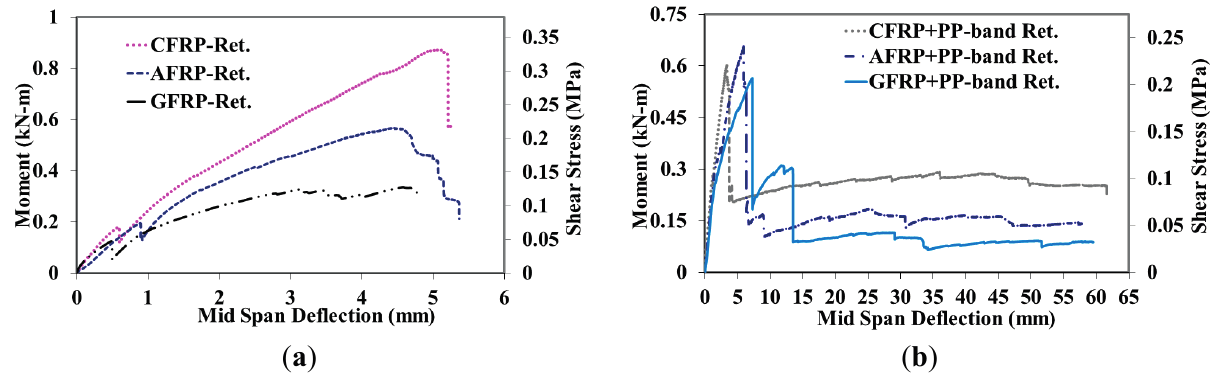
Figure 5. Moment-deflection curves under out-of-plane bending test for ( a ) CFRP, AFRP and GFRP retrofitted masonry panels and ( b ) CFRP + PP-band, AFRP + PP-band and GFRP + PP-band retrofitted masonry